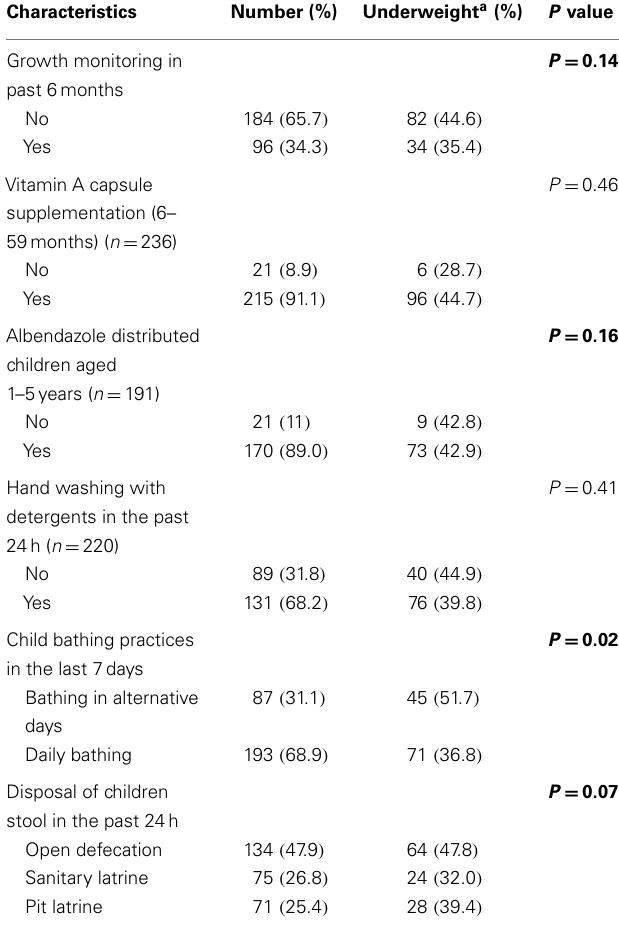
Table 3 | Health and sanitation practices ( n = 280) .